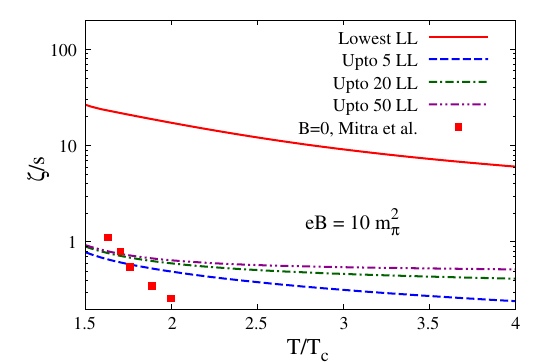
Fig. 1 The temperature dependence of thermal relaxation time for quarks at | eB |= 10 m 2 π